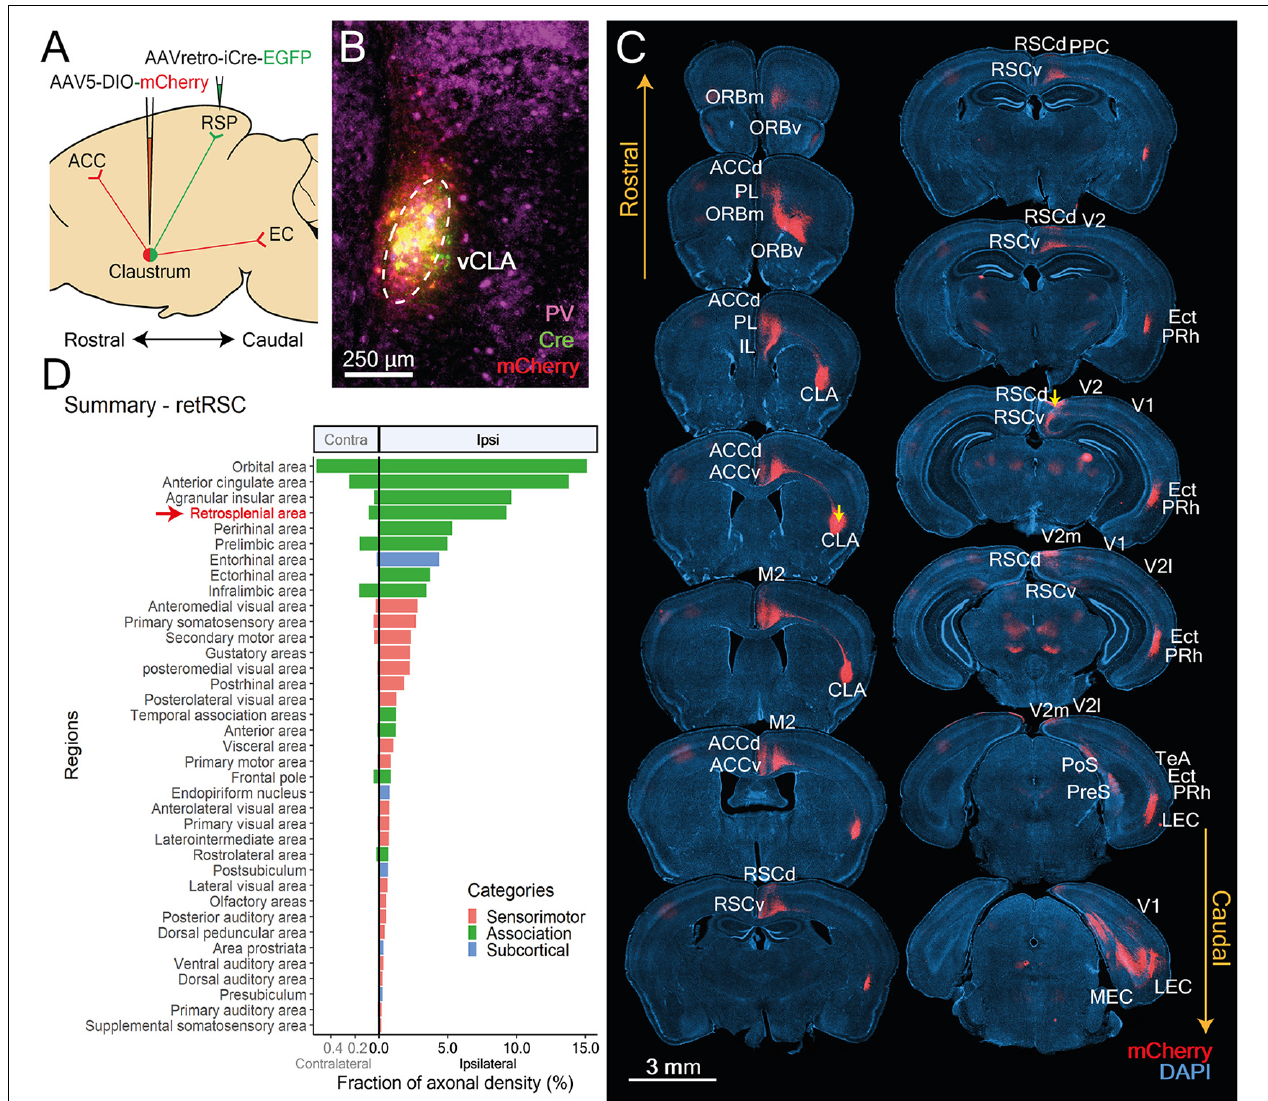
FIGURE 3 | CLA neurons projecting to RSC (retRSC) reside within the ventral CLA core and co-project mainly to higher cortical targets. (A) Double-virus injection strategy used to label CLA neurons projecting to the RSC and its axon arborizations. (B) CLA-specific expression of Cre and mCherry. vCLA core boundaries (white dotted ellipse) are demarcated based on parvalbumin (PV) antibody staining. (C) Mapping of retRSC neuron axons; images show mCherry expression (red) within DAPI-stained (blue) coronal sections. Yellow arrows denote viral injection sites. CLA neurons projecting to RSC also project to several other higher-order cortical structures. Labels indicate regions receiving CLA axons. PL, Prelimbic cortex; ORBm, ORBv, Orbital frontal cortex medial, ventral; ACCd, ACCv, Anterior cingulate cortex dorsal, ventral; IL, Infralimbic cortex; M1, M2, Primary and secondary motor cortex; RSCd, vRSCv, Retrosplenial cortex dorsal, ventral; PPC, Posterior Parietal Cortex; V1, V2, V2 m, V2l, primary and secondary visual cortex, medial, lateral; Ect, Ectorhinal cortex; Prh, Perirhinal cortex; TeA, Temporal association cortex; PreS, Presubiculum; PoS, Postsubiculum; ENTl, ENTm, Entorhinal cortex lateral, medial. (D) Mean fraction of axonal density for all innervated regions, sorted by density. Red arrow and text indicate retrograde Cre origin (RSC). Orbital, anterior cingulate and agranular insula had heavier innervation compared to RSC. Colors represent region categories: Association—green, Sensorimotor—pink, and Subcortical—Blue. Note different ranges for contralateral and ipsilateral